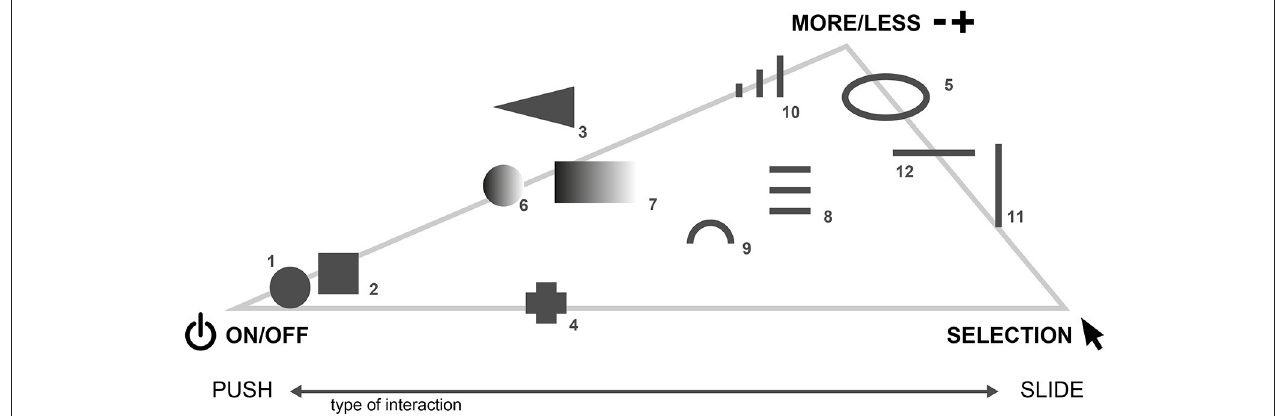
FIGURE 11 | Form-functionality associations based on the forms and functional categories in the Main Study. Some shapes also show a clear tendency toward how the participants would want to interact.